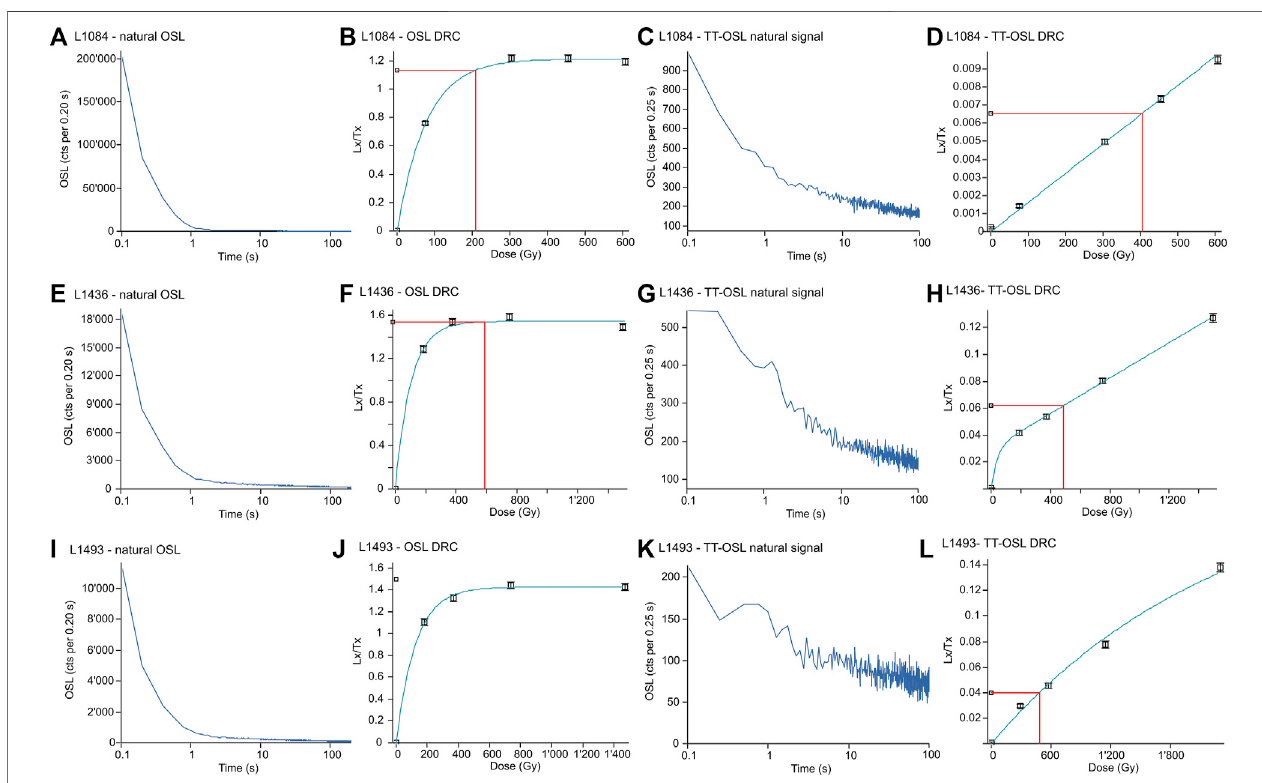
FIGURE3| NaturalOSL (A,E,I) andTT-OSL (C,G,K) signalsofrepresentativesamplesofthestudysitesandtheirrespectiveDRCs (B,F,J) forOSLand (D,H,L) for TT-OSL. Sample L1084 - outcrop in eastern Amazonia; sample L1436 - outcrop in central Amazonia; sample L1493 - Autazes core in central Amazonia.